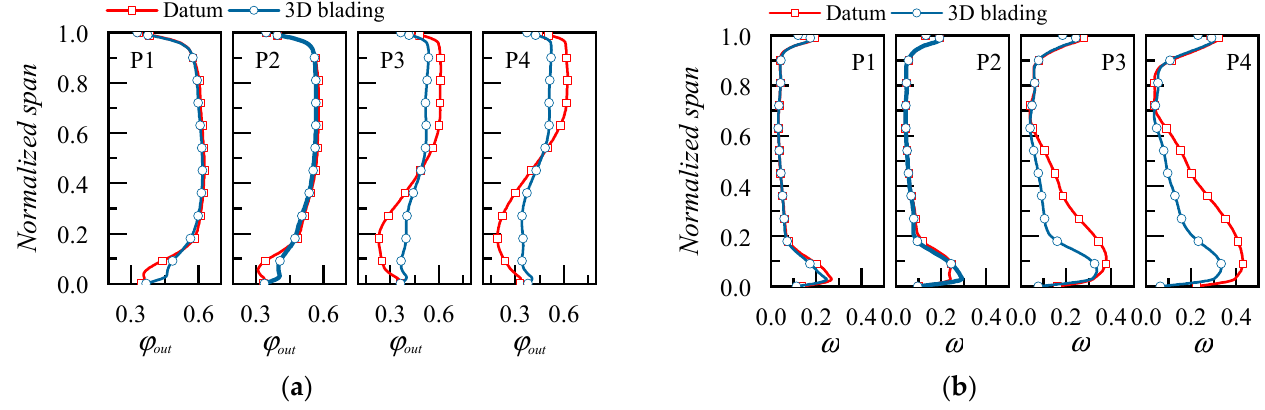
Figure 29. The radial distribution of mass flow coefficient and loss under different operating condi- tions: ( a ) outlet mass flow coefficient; ( b ) total pressure loss.